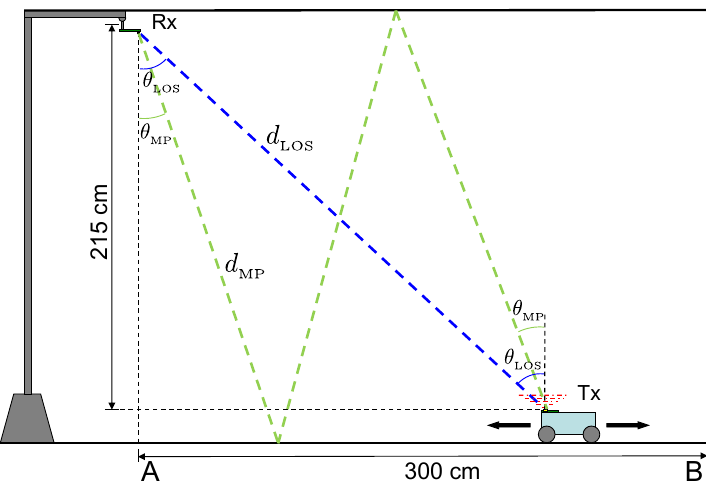
Figure 10. Emitter-receiver IR link defined for the results. LOS propagation path (blue) and one NLOS propagation path (green) due to ceiling-floor